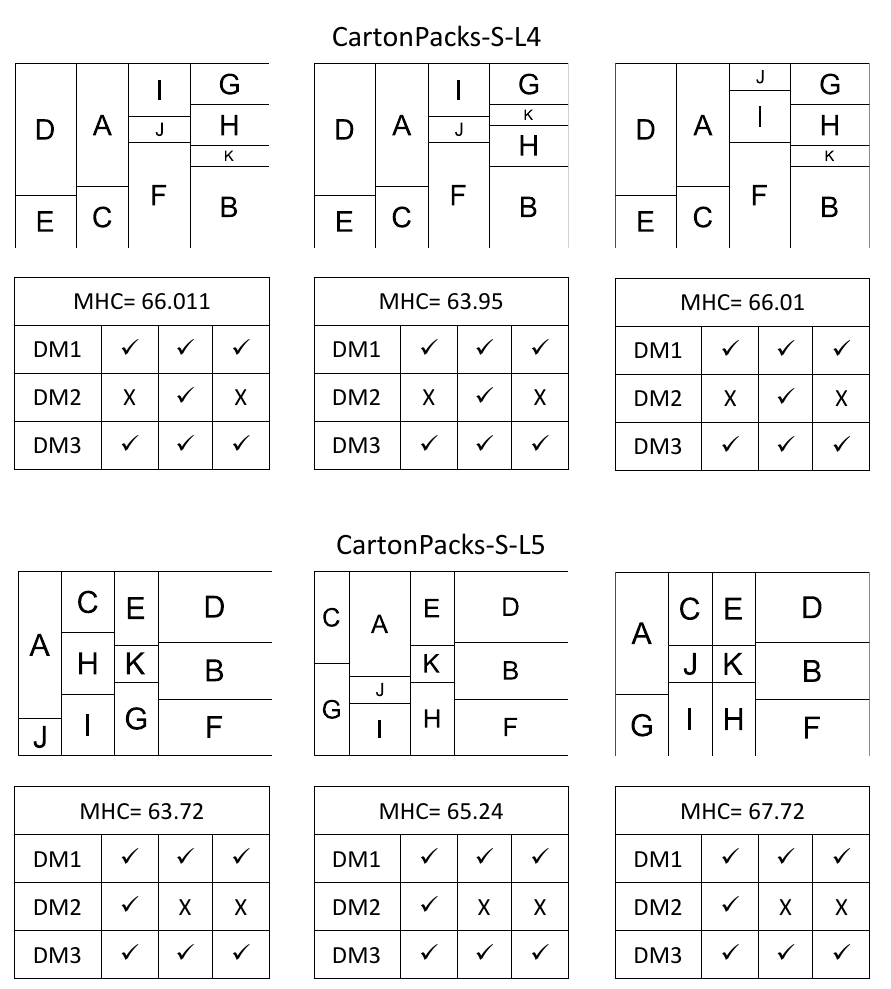
Figure 14. Best solutions found in Sequential launch 4 to 5 of CartonPacks